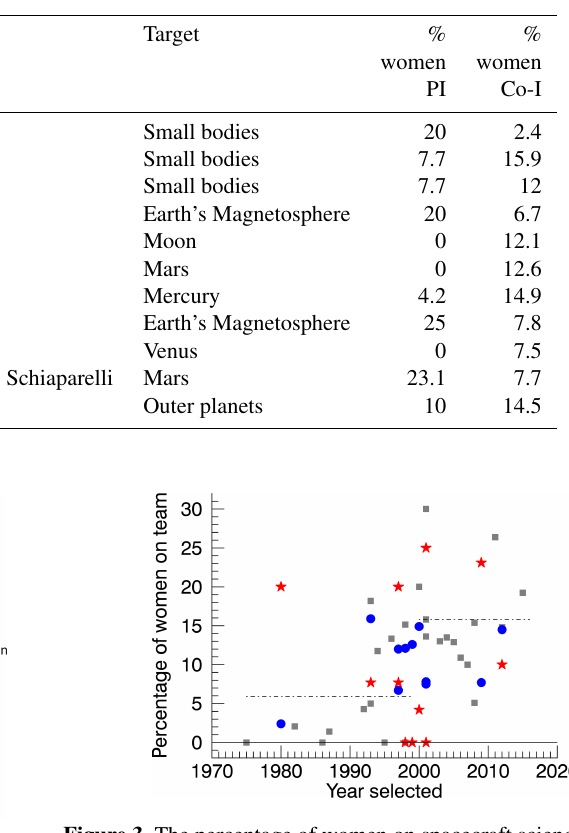
Figure 2. As Fig. 1, but showing the number of Co-Is (Co- Investigators) team members on ESA planetary missions.